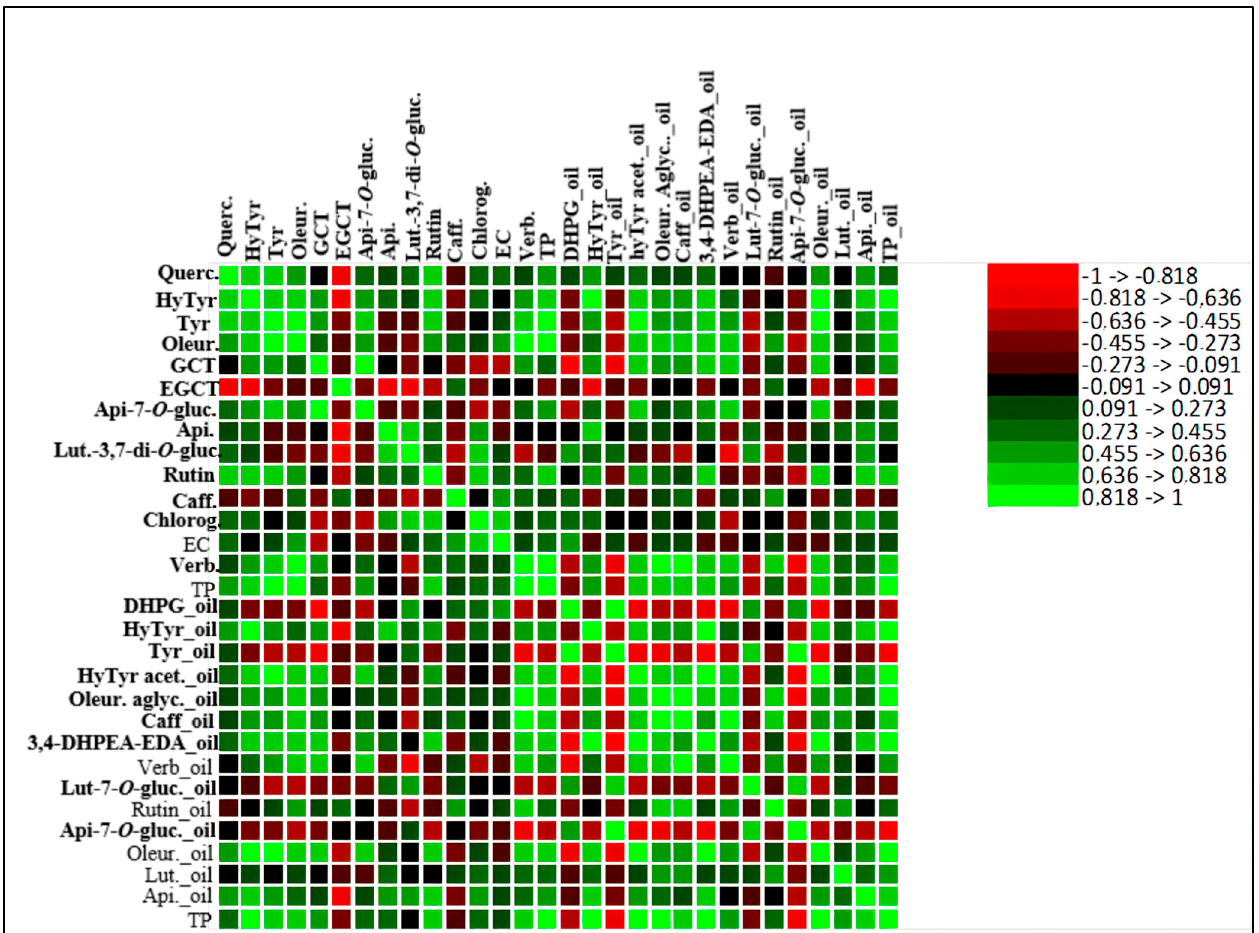
Figure 4. Heatmap of the correlation matrix between olive fruit phenolic compounds and olive oil phenolic compounds. Apigenin-7- O -glucoside (Api-7- O -gluc.), caffeic acid (Caff), luteolin-7- O -glucoside (Lut-7- O -gluc.), luteolin-3,7-di- O -glucoside (Lut-3,7-di- O -gluc), rutin, verbascoside (Verb.), 3,4-dihydroxyphenylglycol (DHPG), oleuropein aglycone (Oleur. aglyc.), tyrosol (Tyr), dialdehydic forms of decarboxymethyl elenolic acid linked to hydroxytyrosol (3,4-DHPEA-EDA), hydroxytyrosol (HyTyr), apigenin (Api.), total phenols (TP), oleuropein (Oleur.), luteolin (Lut.), hydroxytyrosol acetate (HyTyr acet.), epigallocatechin (ECGT), epicatechin (EC), gallocatechin (GCT), chlorogenic acid (Chlorog.), quercetin-3,7-di- O -glucoside (Querc.).